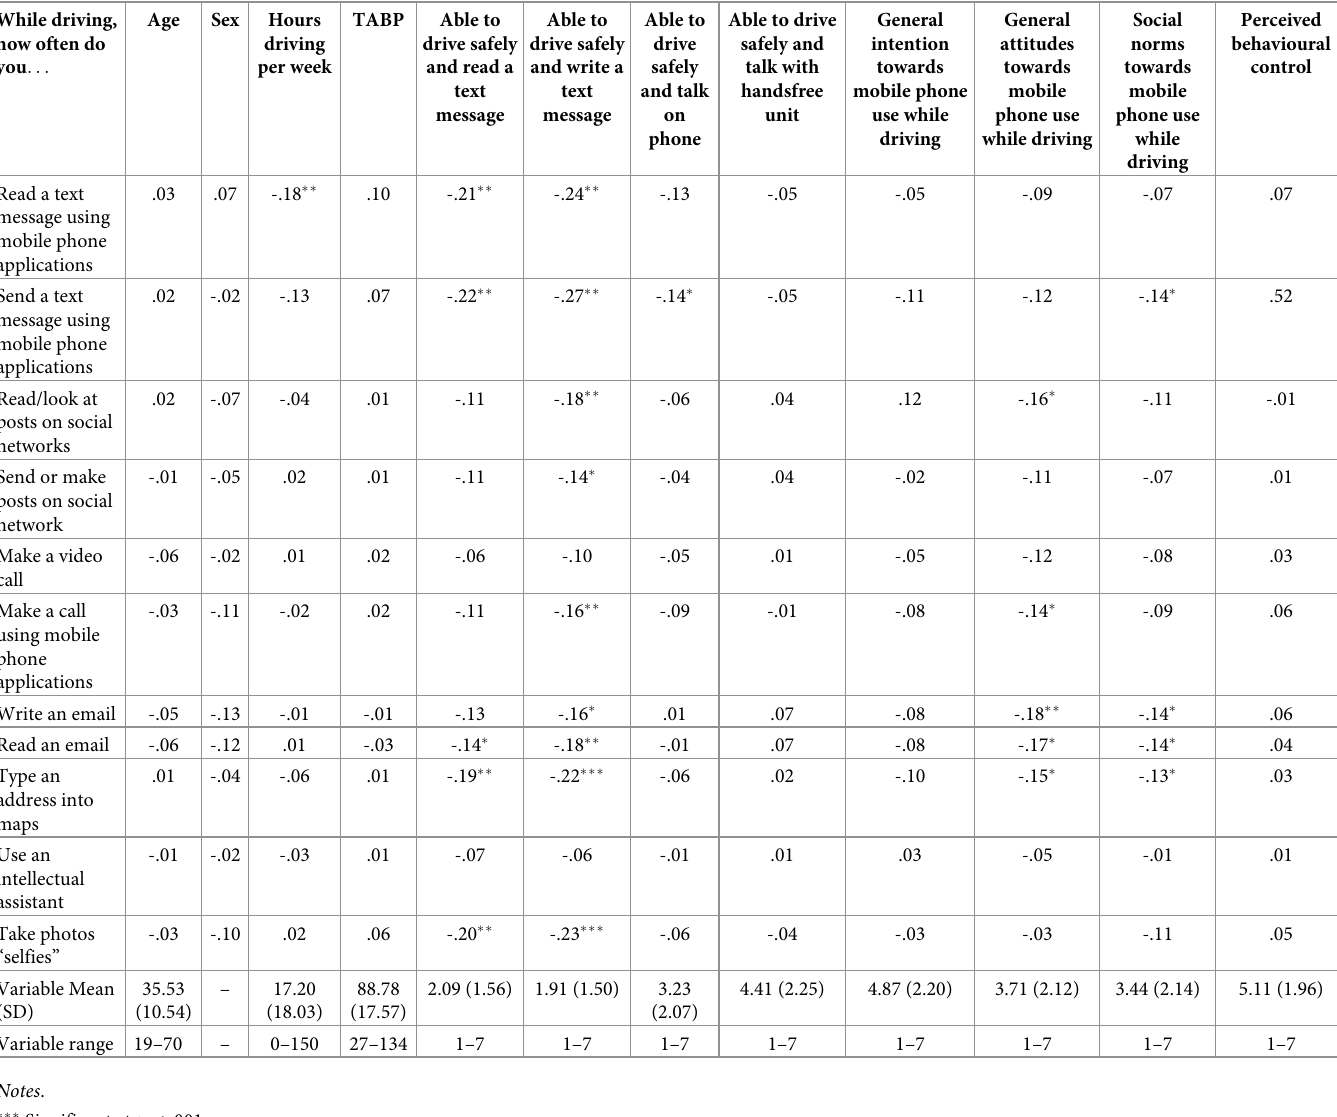
Table 2. Associations between engagement with different mobile phone applications while driving and age, sex, hours driven per week, TABP, specific beliefs about being able to engage in secondary tasks and drive safely, and TPB variables (N = 220). While driving, how often do you